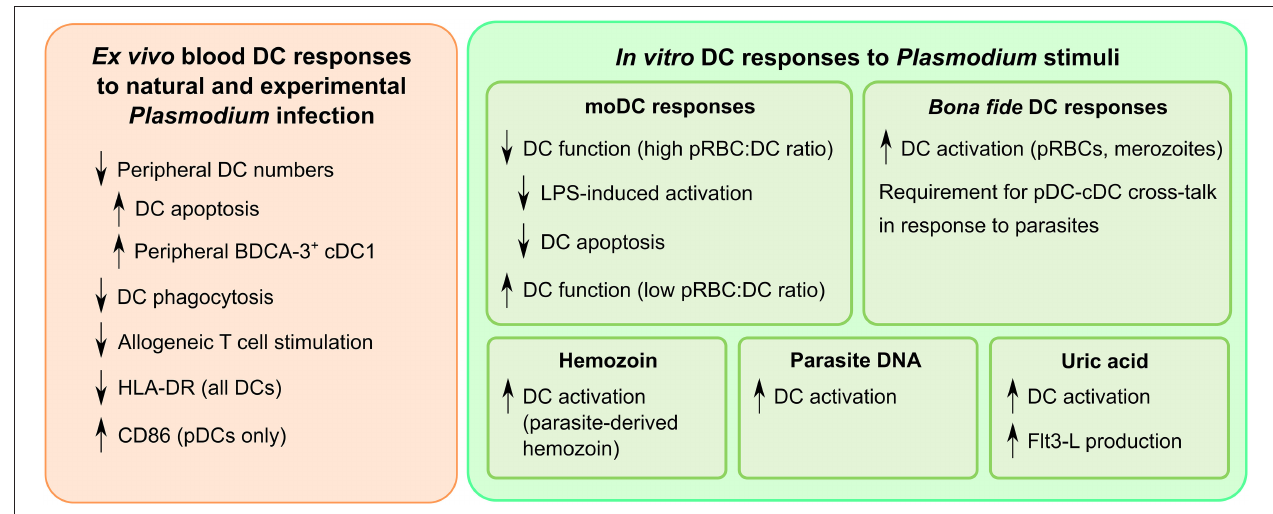
FIGURE 3 | A summary of dendritic cell responses to Plasmodium . While the dendritic cell response is heterogeneous, certain trends are evident when examining the entirety of the current literature. Downregulation of dendritic cell function is commonly observed in field studies of infected humans. In vitro studies have yielded insight into the complexities of dendritic cell activation by Plasmodium , particularly the types of ligands that can trigger an inflammatory response.